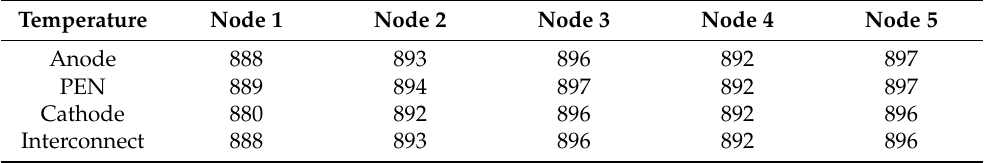
Table 6. Temperature distribution of SOFC stack nodes in normal condition.